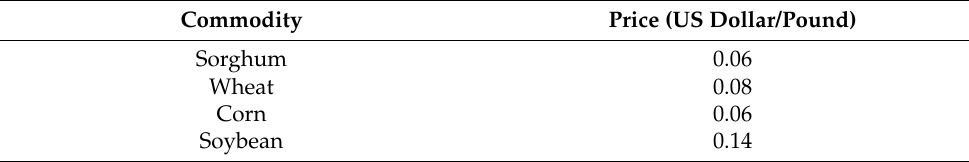
Table 2. Different grains’ price in 2020.